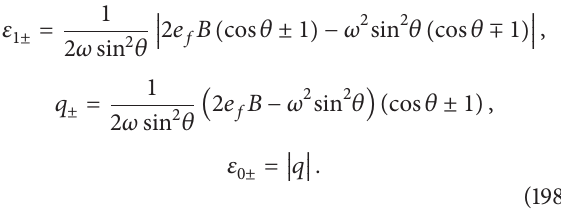
, 𝑇 = 400 MeV, and 𝑦 = 0 (dashed line). 𝑚 𝜋